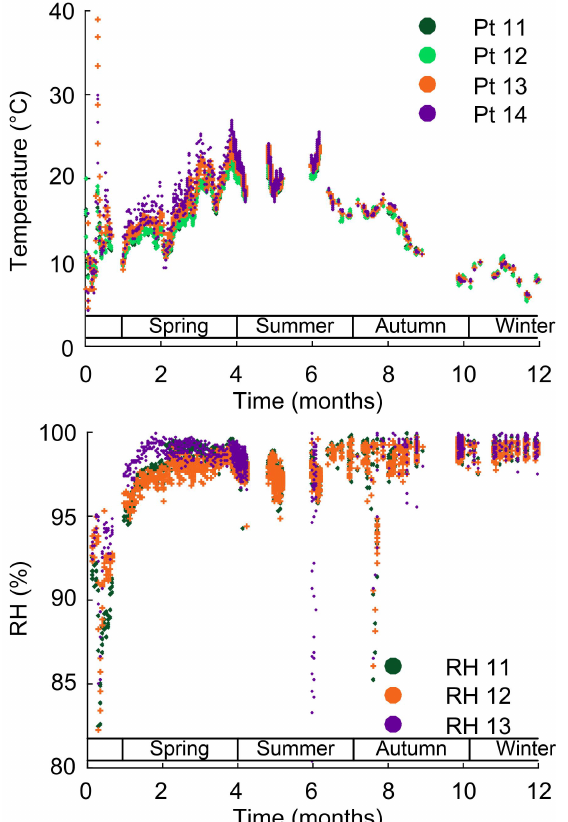
Figure 15. Temperature and relative humidity measured in beam 1 during the first